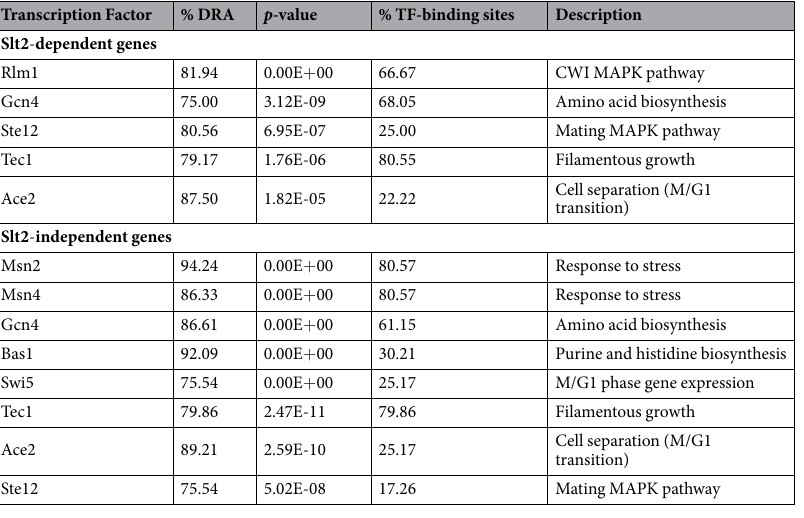
Table 1. Transcription factor regulation enrichment for genes included in the genome-wide transcripcional response to caspofungin. DRA, percentage of genes showing documented regulatory associations with transcription factors ( p -value < 0.001) as deduced from analysis with YEASTRACT. Those transcription factors with DRA percentages higher than 75%, ordered by p -value, are shown. Percentage of genes showing in their promoters at least one DNA-binding domain for each indicated transcription factor is also